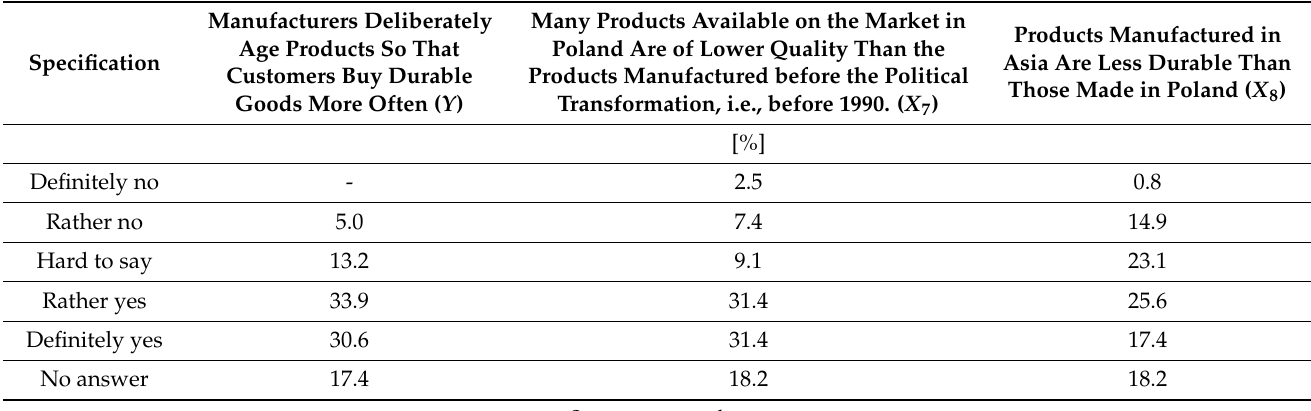
Table 1. Opinions of respondents on the deliberate aging of products and the differences in product quality in Poland compared to the period before 1990 or compared to products from Asia.